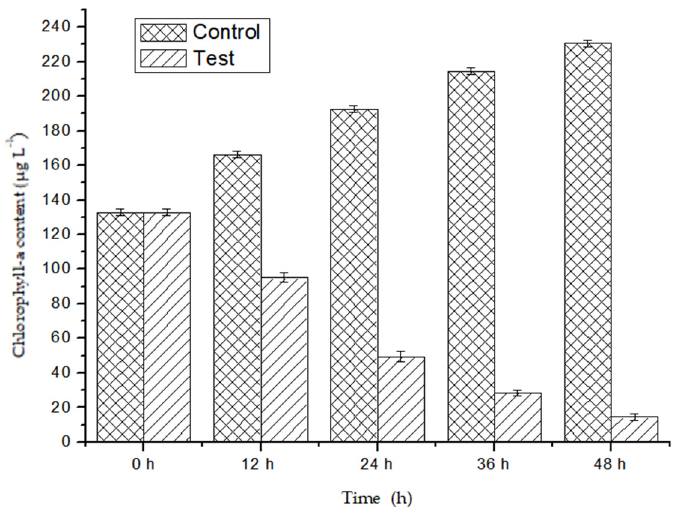
Figure 1. Algicidal e ffi ciency of Phanerochaete chrysosporium : Microcystis aeruginosa alone and M. aeruginosa treated by P. chrysosporium . Data are expressed as the mean ± SD ( n = 3).